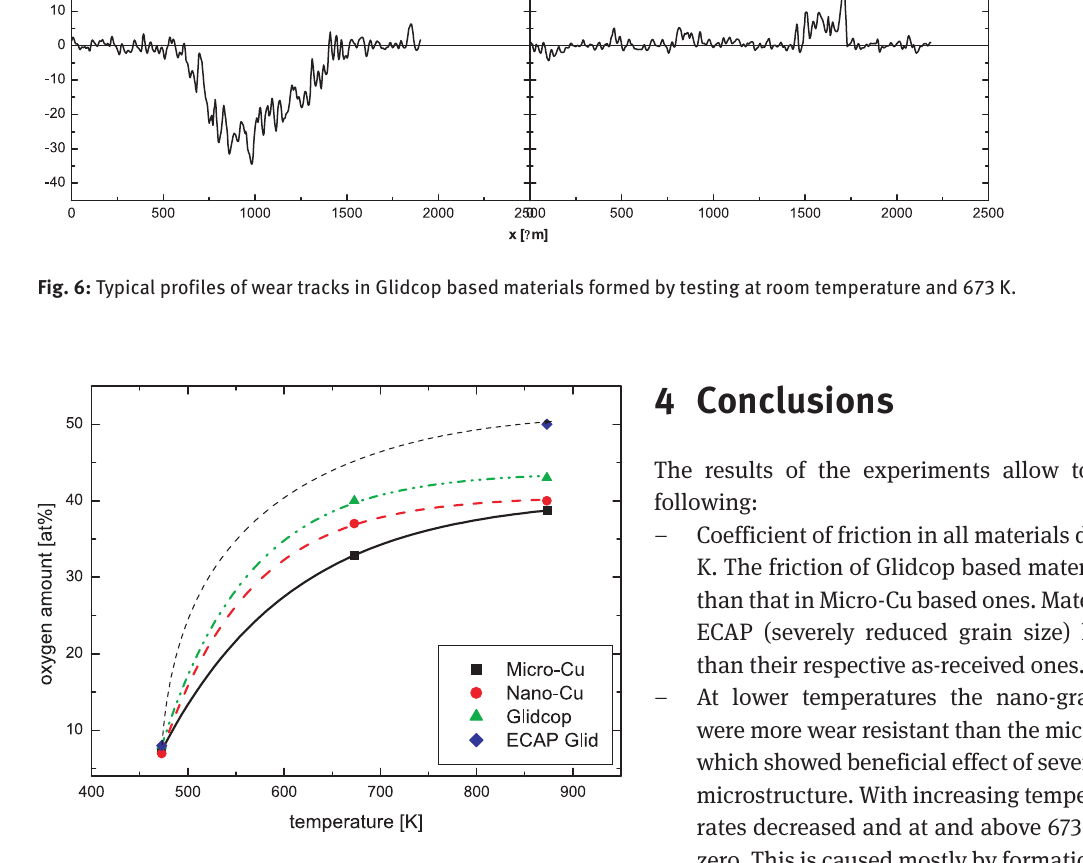
Fig. 7: Concentration of oxygen (in atomic %) on the surfaces of the four materials tested at various elevated